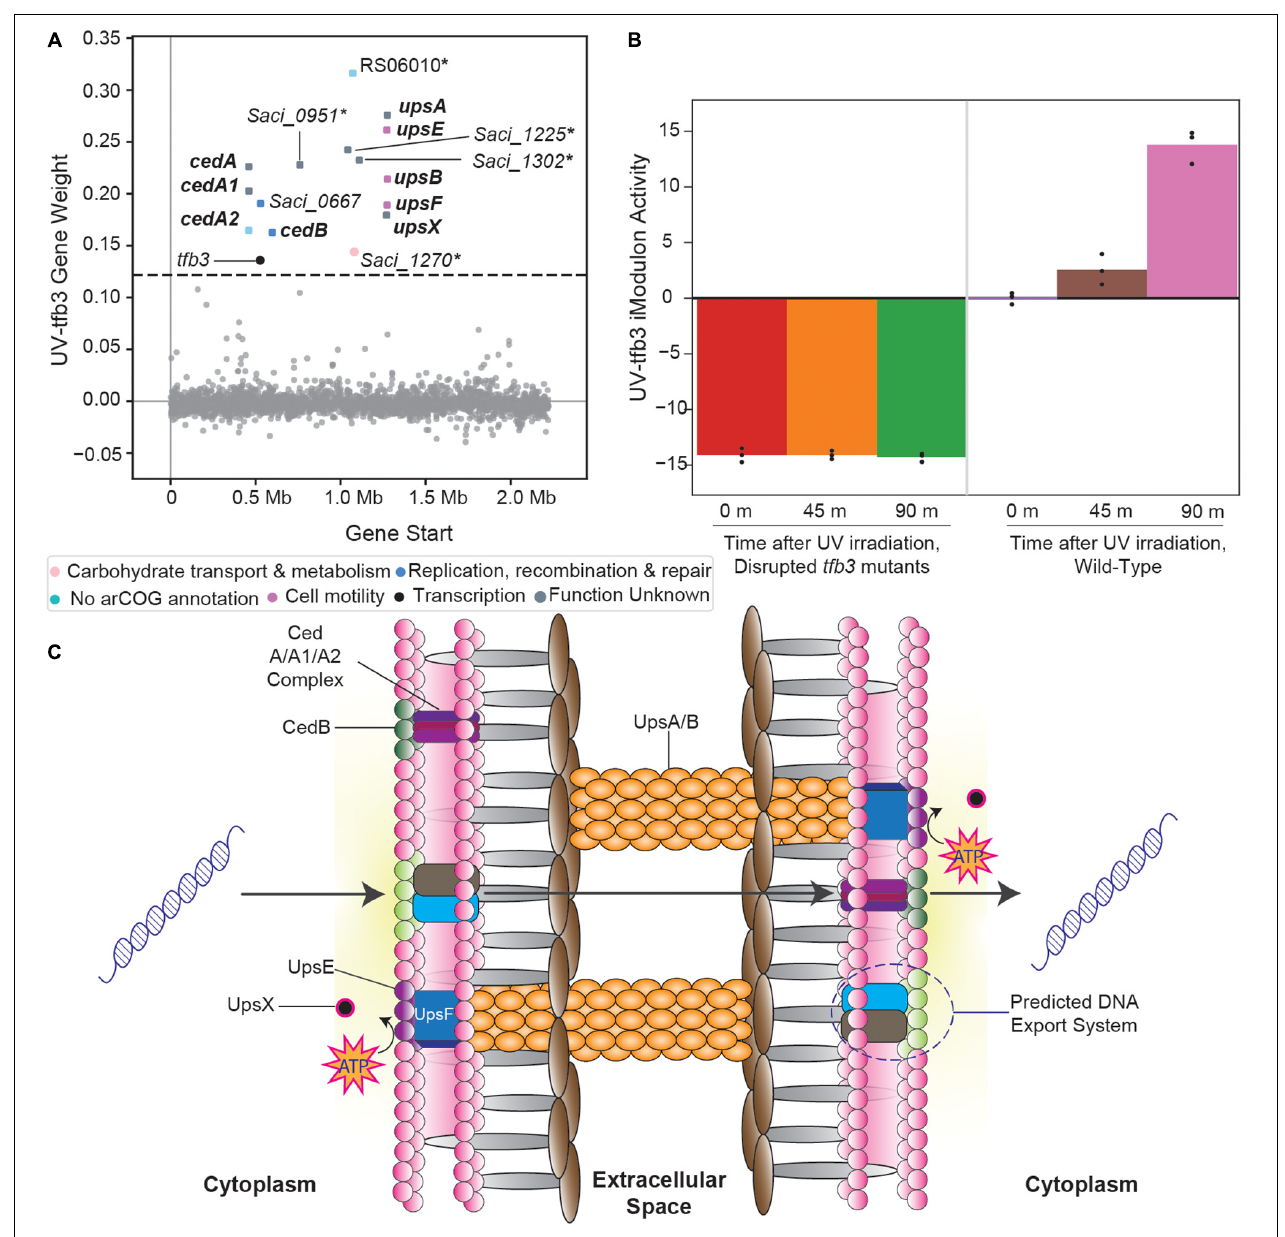
FIGURE 4 | Overview of the tfb3 -dependent UV-stress response iModulon (UV-tfb3). (A) Scatter plot of the UV-tfb3 iModulon gene weights. Genes are colored by COG categories. Genes in bold are part of the known tfb3 -dependent response (Götz et al., 2007; Ajon et al., 2011; van Wolferen et al., 2013, 2015, 2016; Schult et al., 2018). Genes with an asterisk are proposed to make up the DNA export system. (B) UV-tfb3 iModulon activity plotted over time after UV-irradiation. The left three bars show the activities of the tfb3 insertion mutants (relative to wild-type cells before UV irradiation). The right three bars show the activities of the wild-type cells (relative to wild-type cells before UV irradiation). (C) A visual overlay of the tfb3 -dependent UV-stress response (Ajon et al., 2011; van Wolferen et al., 2013, 2015, 2016).